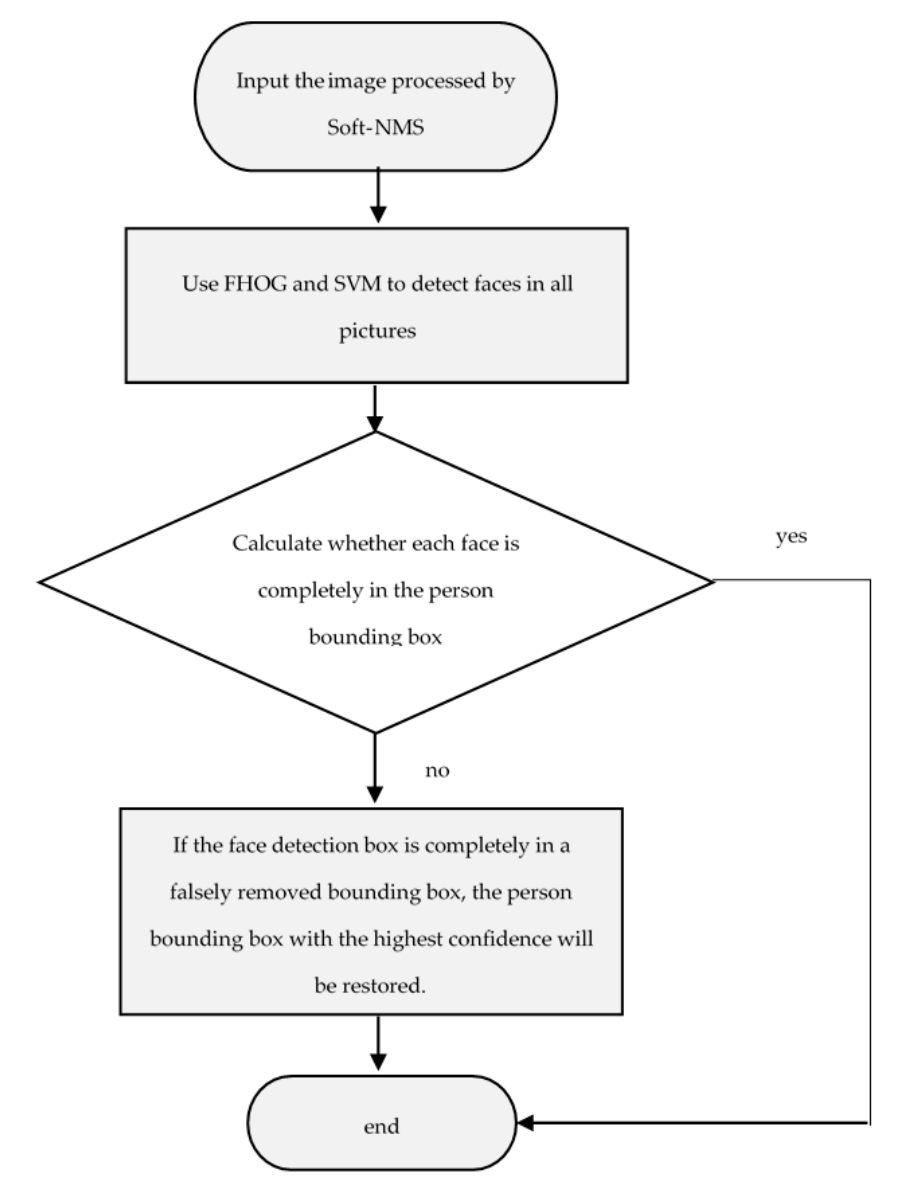
Figure 6. Flow chart of the retrieval algorithm. FHOG: Felzenszwalb histogram of oriented gradient; SVM: support vector machine.